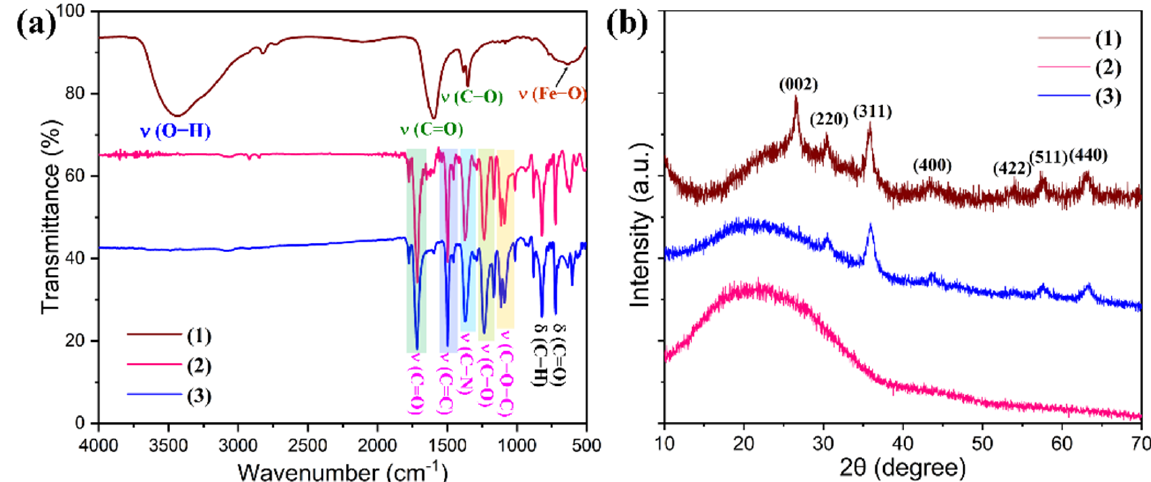
Figure 5. ( a ) FTIR spectra and ( b ) XRD patterns of (1) graphene/Fe 3 O 4 hybrid, (2) pure PI aerogel film, and (3) the PI/graphene/Fe 3 O 4 hybrid aerogel film.